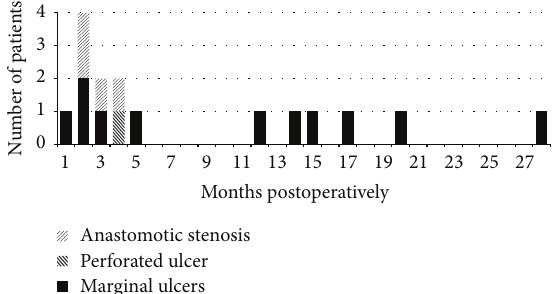
Figure 2: Incidence and type of complications at the gastrojejunal anastomosis over